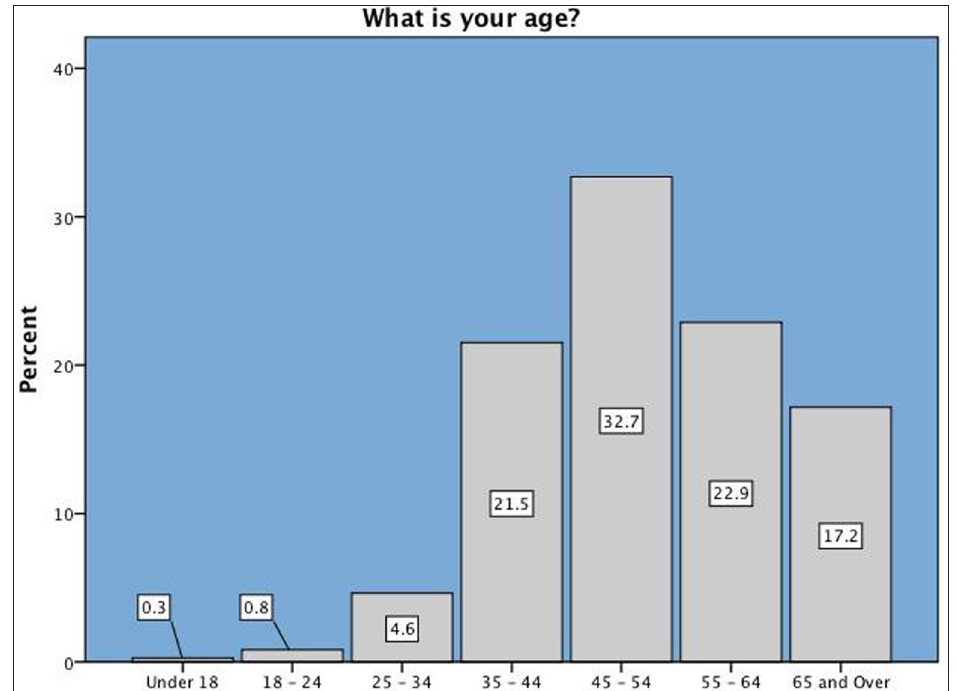
Figure 2: Age grouping of questionnaire respondents (n =